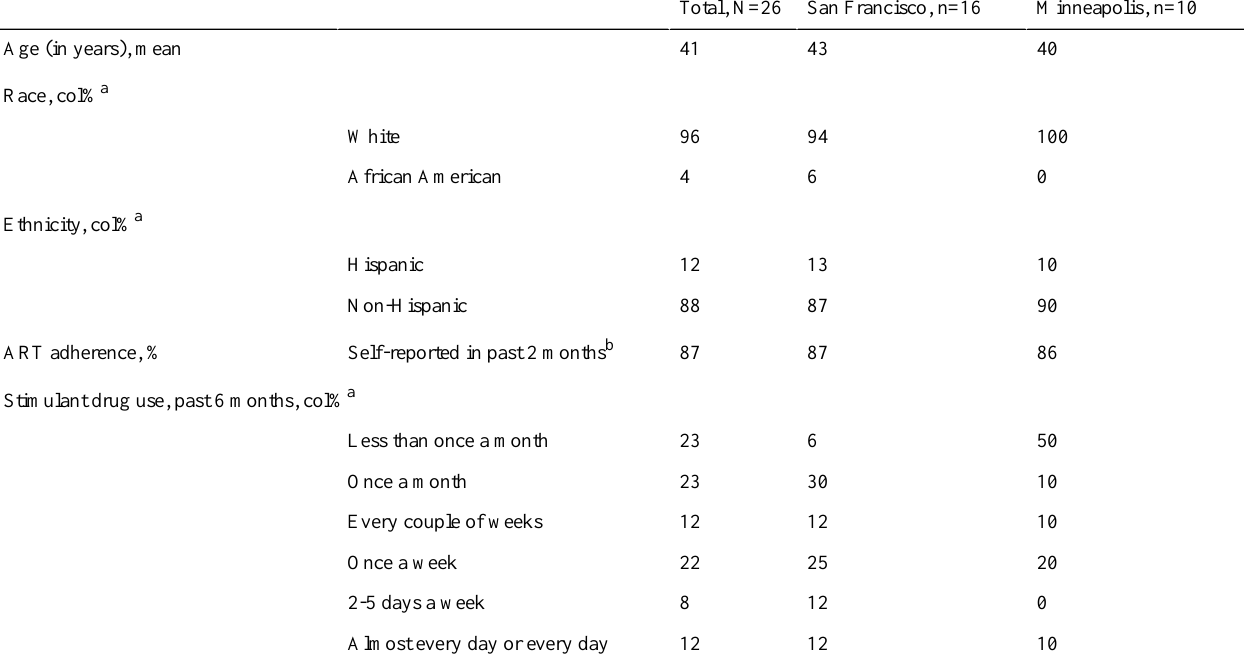
Table 1. Focus group sociodemographic